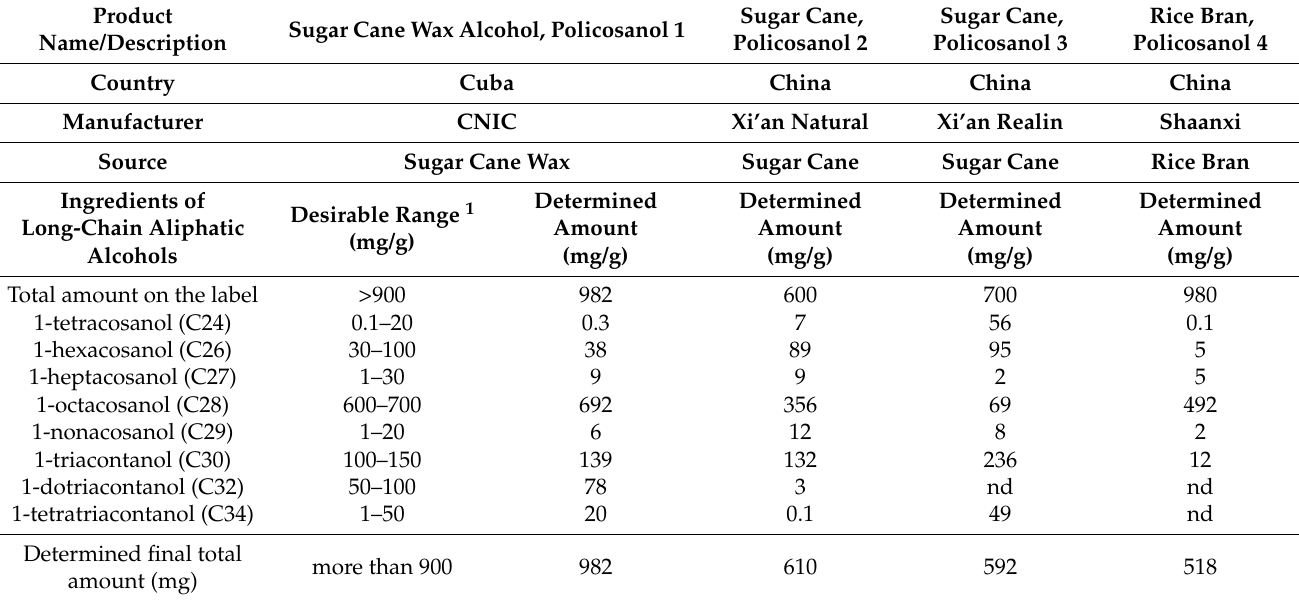
Table 1. Total wax alcohol contents and ingredient compositions from different products of